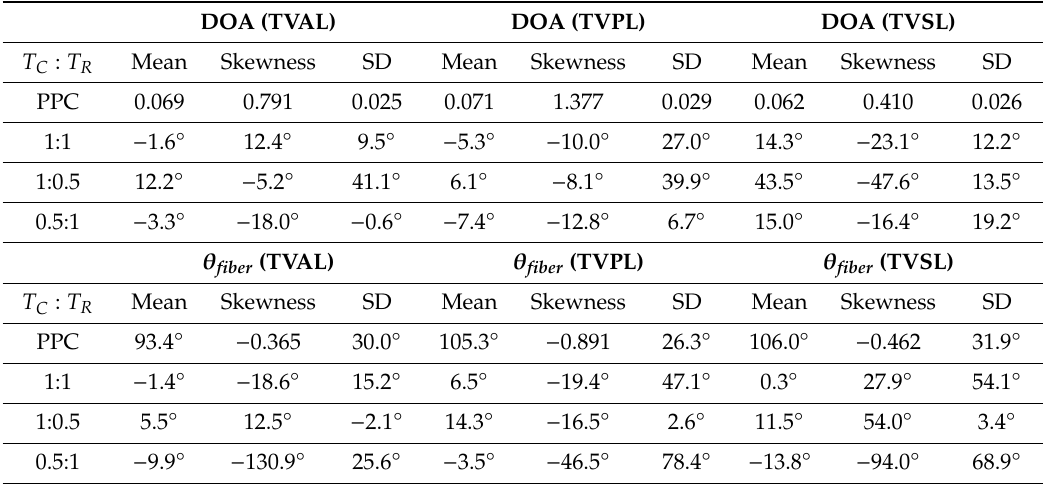
Table A1. The percentage changes in mean, skewness, and standard deviation (SD) for the predicted θ fiber and the DOA of the entire tissue’s ROI for the TVAL, TVPL, and TVSL specimens of heart #2.